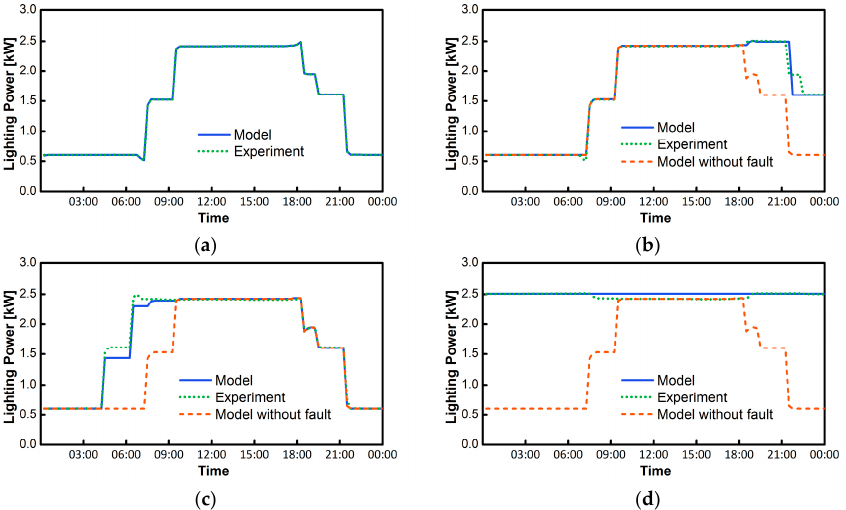
Figure 8. Lighting power consumptions of baseline and faulted scenarios: lighting setback error. ( a ) baseline; ( b ) delayed onset; ( c ) early termination; ( d ) no setback.